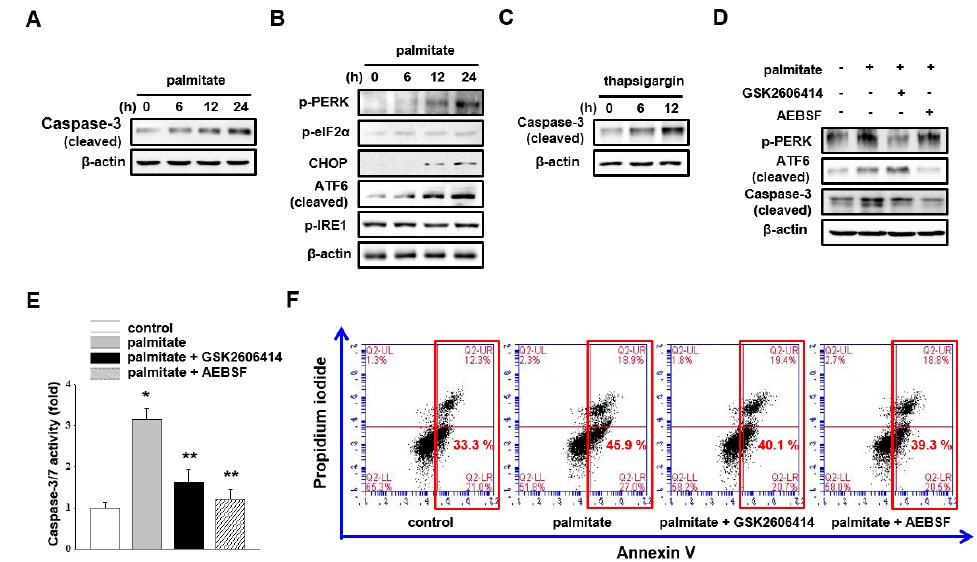
Figure 1. Lipotoxicity induces mesangial cell apoptosis via protein kinase RNA-like endoplasmic reticulum kinase (PERK) and ATF6 signaling pathways. ( A , B ) Mesangial cells were treated with 30 µ M palmitate for various time intervals. Cell extracts were subjected to western blot analysis with indicated antibodies. The representative immunoblots were from at least three independent experiments; ( C ) mesangial cells were treated with 50 nM thapsigargin for 6 h and 12 h. Cell extracts were subjected to western blot analysis with caspase-3 antibody. The representative immunoblots were from at least three independent experiments; ( D – F ) mesangial cells were pretreated with 1 µ M GSK2606414 or 100 µ M AEBSF. After 30 min, cells were treated with 30 µ M palmitate for 24 h; ( D ) cell extracts were subjected to western blot analysis with indicated antibodies. The representative immunoblots were from at least three independent experiments; ( E ) caspase 3/7 activity was measured. Data represent the mean ± SEM of three independent experiments, each performed in triplicate. * p < 0.05 vs. control, ** p < 0.05 vs. palmitate; ( F ) annexin V and propidium iodide stainings were analyzed. Red frame indicates the sum of early and late apoptotic cells. Representative images were from at least three independent experiments.